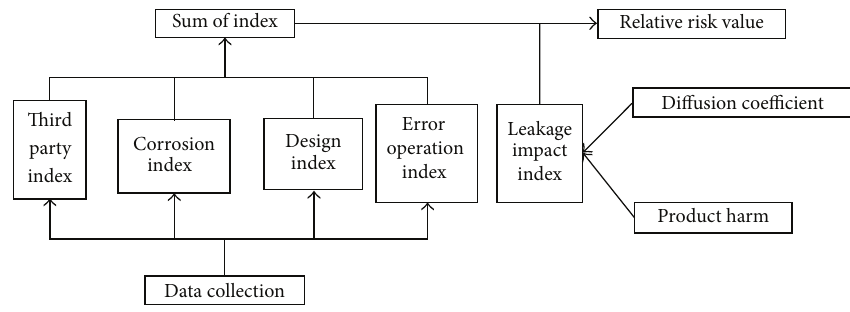
Figure 1: Evaluation process of the Kent index